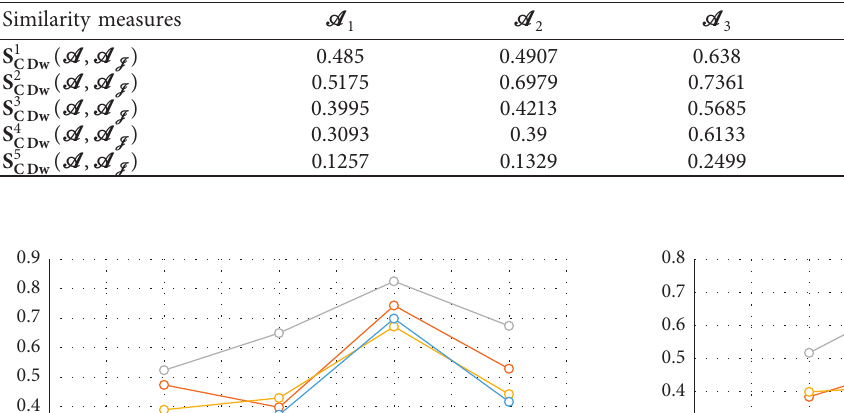
, ϕ ) � ( 0 . 5 , 0 . 5 ) . cc cc